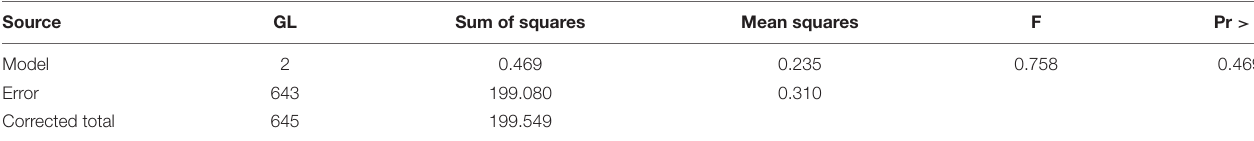
FIGURE 4 | Profile of the classes. TABLE 6 | Analysis of variance (ANOVA) between the subject-based (ITT) approach and the classes on the use of heritage. Source GL Sum of squares Mean squares F Pr > F Model Corrected total Calculated against the Y model Y = Mean